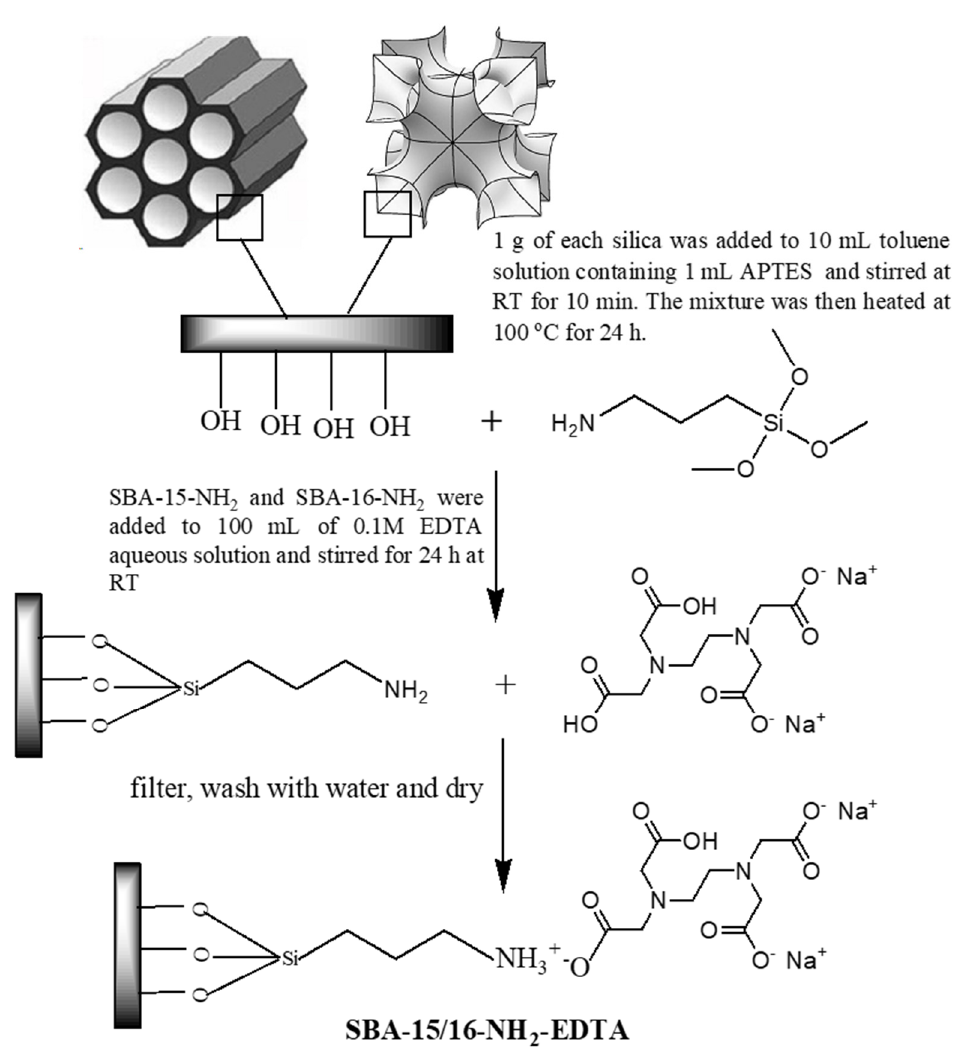
Figure 1. Modification of SBA ‒ 16 and SBA ‒ 15 with APTES and EDTA.